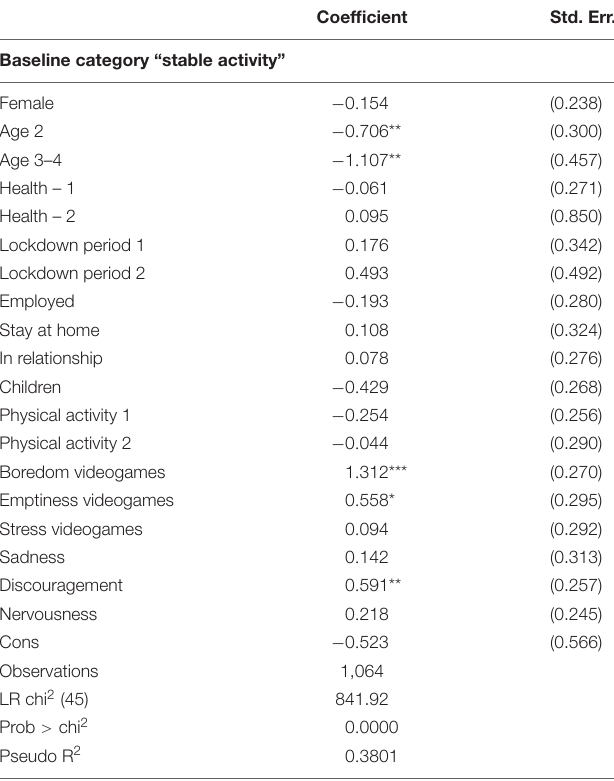
TABLE 6B | Multinomial logistic regression on videogame play increase: category “increased activity”. Coefficient Std. Err.